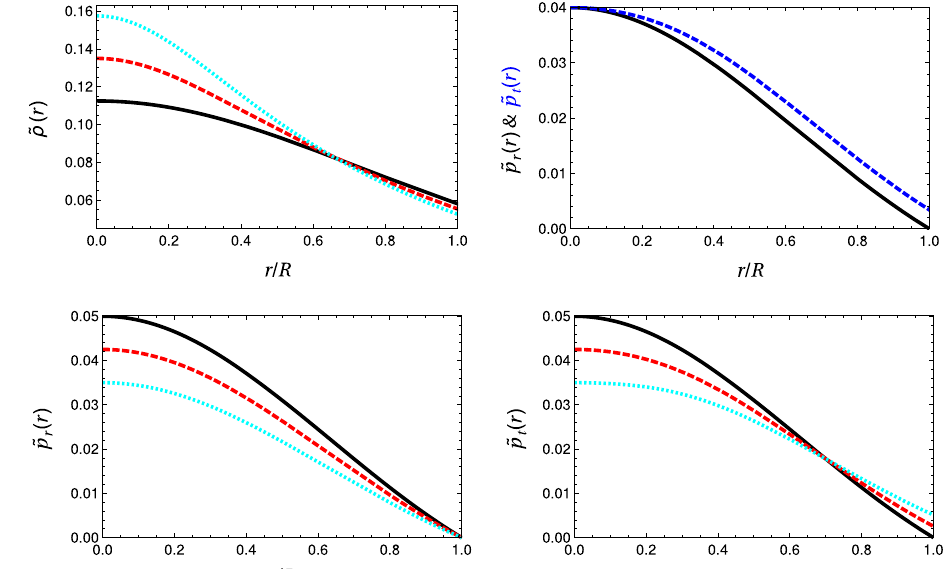
cyan line) represent two anisotropic solutions. The second graph shows a comparison between the radial and tangential pressure for α = 0 . 2. The anisotropy causes the pressures values to drift apart